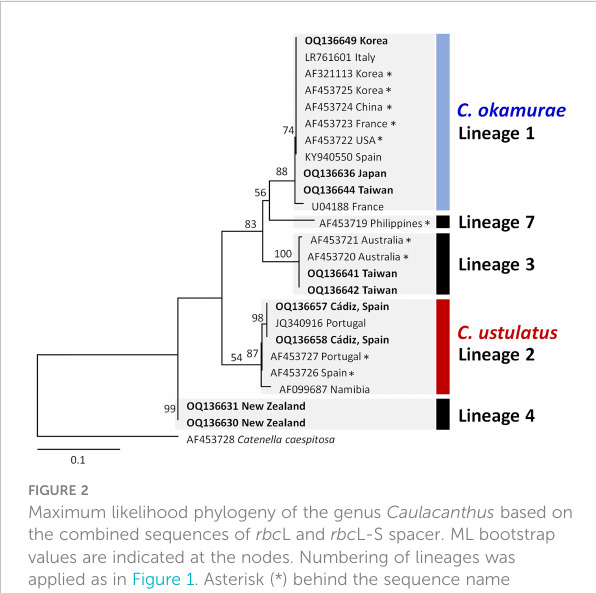
FIGURE 2 Maximum likelihood phylogeny of the genus Caulacanthus based on the combined sequences of rbc L and rbc L-S spacer. ML bootstrap values are indicated at the nodes. Numbering of lineages was applied as in Figure 1. Asterisk (*) behind the sequence name indicates the rbc L-S sequences downloaded from the GenBank. Bold type indicates the sequences generated in this